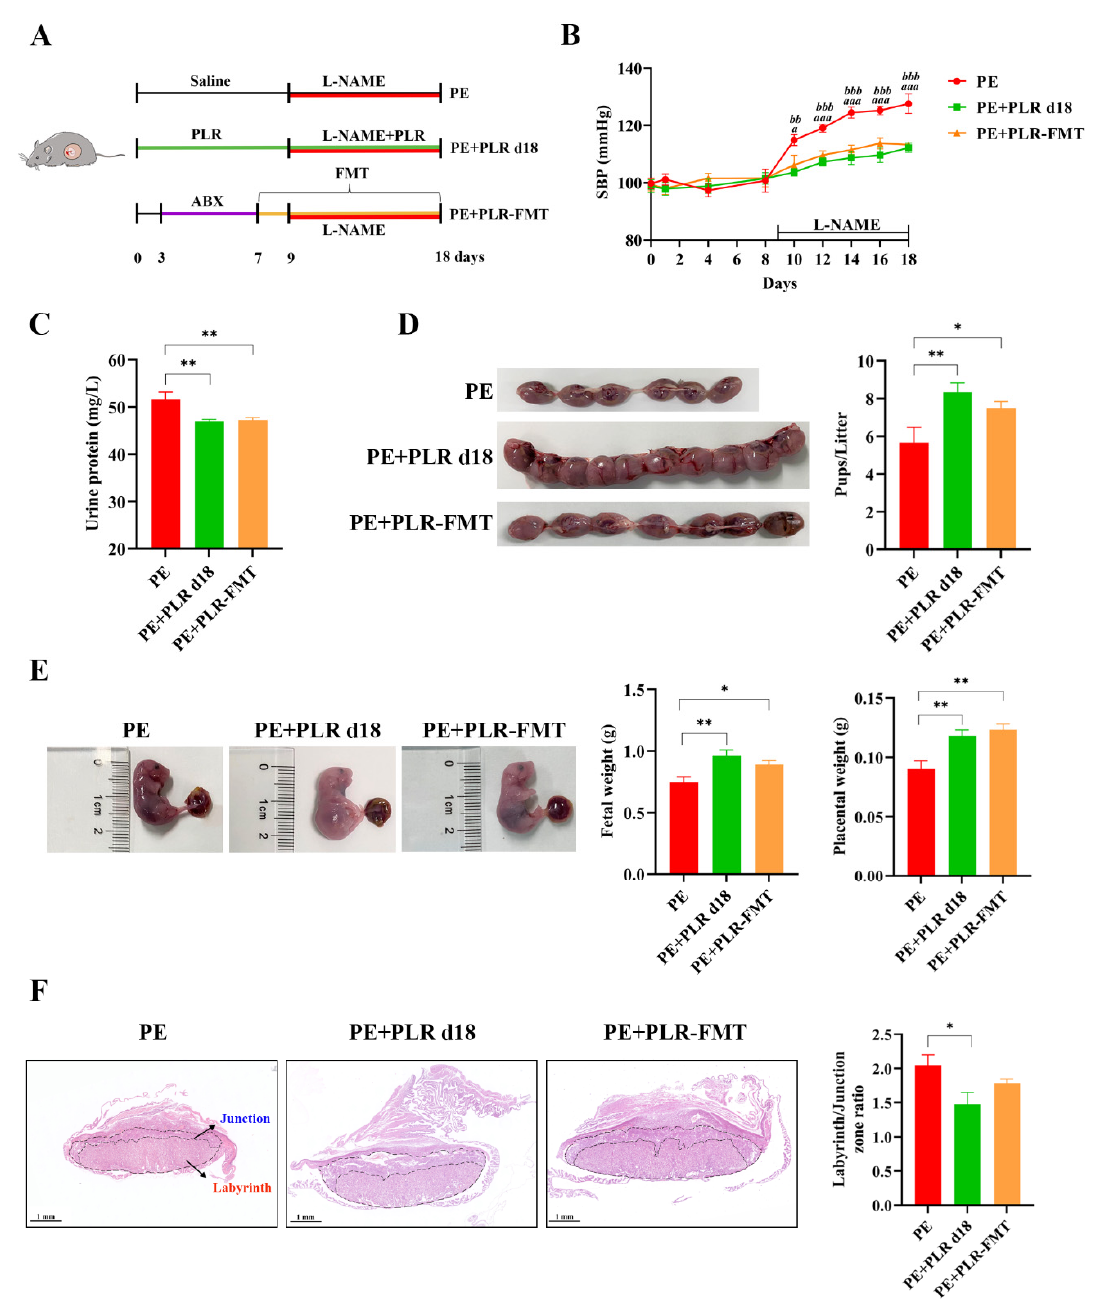
Figure 8. Transplantation of feces from mice treated with PLR improved symptoms of PE in mice. ( A ) The schematic diagram of the experimental design and procedure. ( B ) The SBP of three groups was measured non-invasively. a indicates p < 0.05 and aaa indicates p < 0.001 for the PE+PLR d18 group versus the PE group on the corresponding day. bb indicates p < 0.01 and bbb indicates p < 0.001 for the PE+PLR-FMT group versus the PE group on the corresponding day. ( C ) The 24 h proteinuria on GD18. ( D ) Number of pups per litter. ( E ) Fetal weight and placental weight in different groups. ( F ) Representative images of H&E-stained midsagittal placental tissue sections used in histomorphological analysis (original magnification, ×25; scale bar, 1 mm). Zones are marked and indicated by labyrinth zone and junctional zone. For ( A – E ), n = 7 for each group. For ( F ), n = 6 for each group. Data are expressed as the mean ± SEM. * p < 0.05, ** p < 0.01 (ANOVA test).